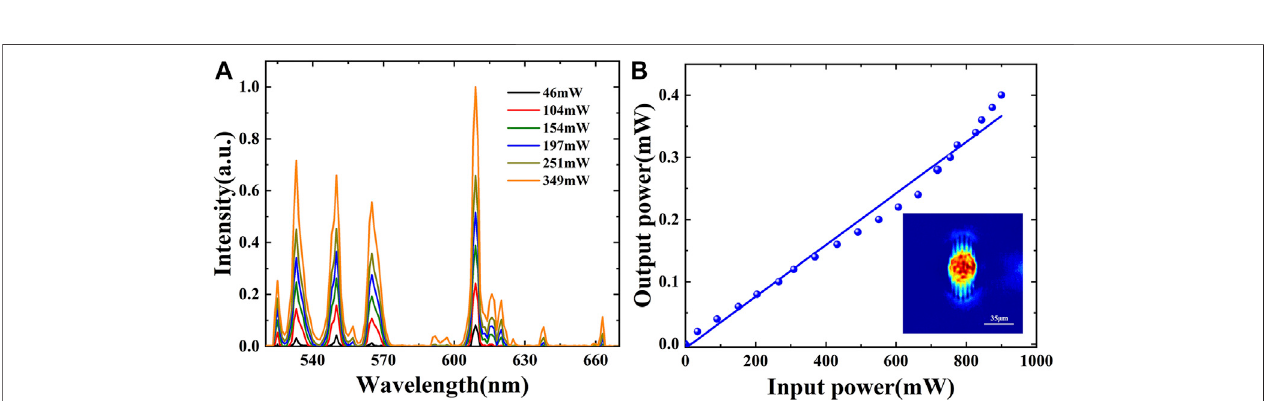
FIGURE4|(A) Fluorescence spectraaround 609 nm obtained from 35waveguides and bulk material under450 nm diode laser excitation. The insetof (A) shows the visible fl uorescence generated in WG16. (B) The dependence of relative intensities of 609 nm emission lines on the fabrication parameters.